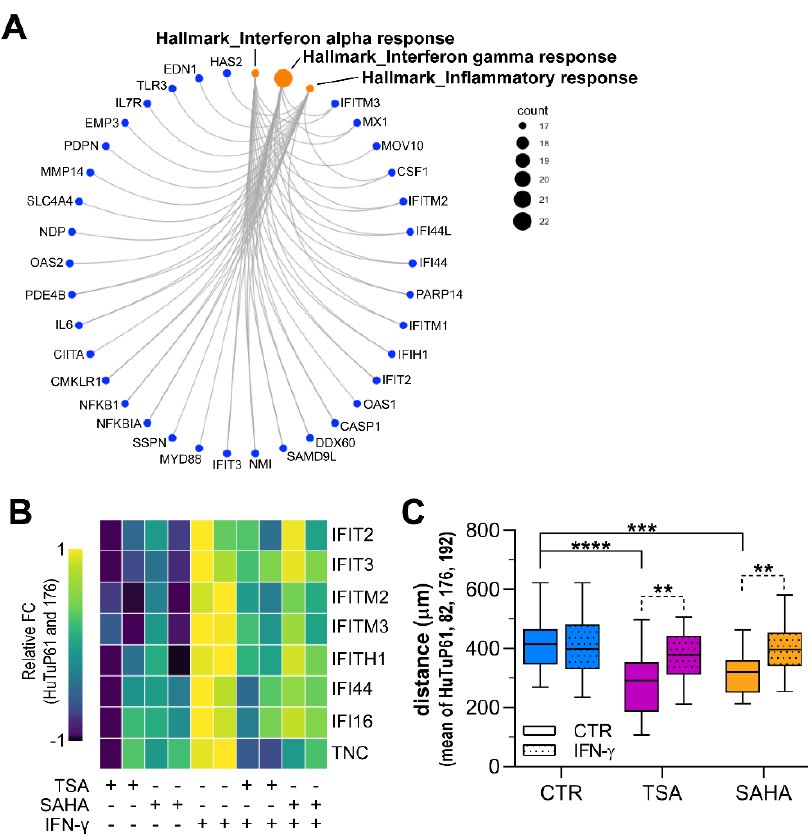
Figure 7. HDI-induced inhibition of cell motility is partially dependent on IFN target gene suppression. ( A ) Circle plot representing HDI-induced DEGs contributing to a significant negative enrichment (FDR q value < 0.05) of the transcriptional Hallmarks (Hallmarks gene sets from MSigDB) correlated to the IFN- α/γ and inflammatory responses. ( B ) Heatmap summarizing the relative expression of a series of IFN/inflammation signaling target genes as indicated when GBM cells (HuTuP61, 176) were exposed to TSA (5 µ M), SAHA (5 µ M), IFN- γ (1 µ g/mL), or a combination of them for 24 h. ( C ) Box plot summarizing the total length covered by cells (HuTuP61, 82, 176, 192, 197) when treated with TSA (1 µ M) and SAHA (2 µ M) (combined or not with 1 µ g/mL IFN- γ ) during a 16-h live imaging experiment. ** p < 0.01, *** p < 0.001, **** p < 0.0001 by t test or one-way ANOVA multiple comparison